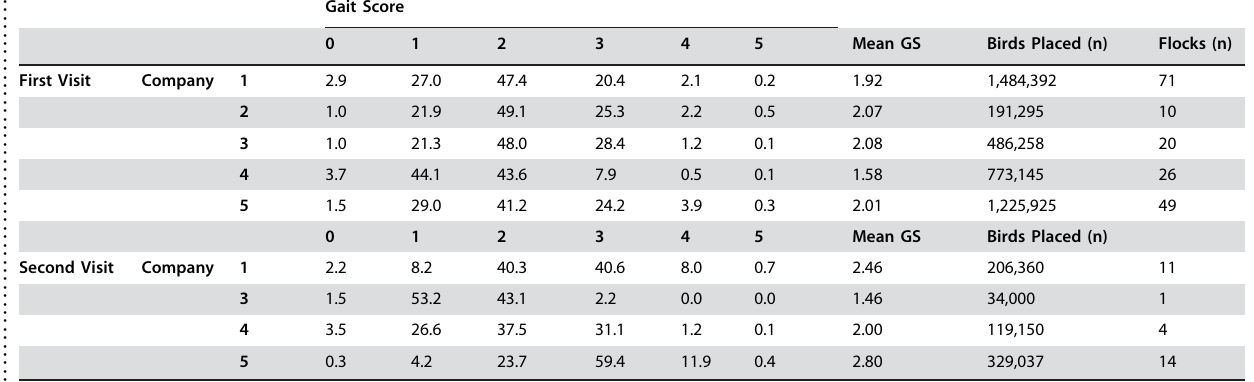
The table also shows the mean gait score and the number of birds represented in terms of birds placed.